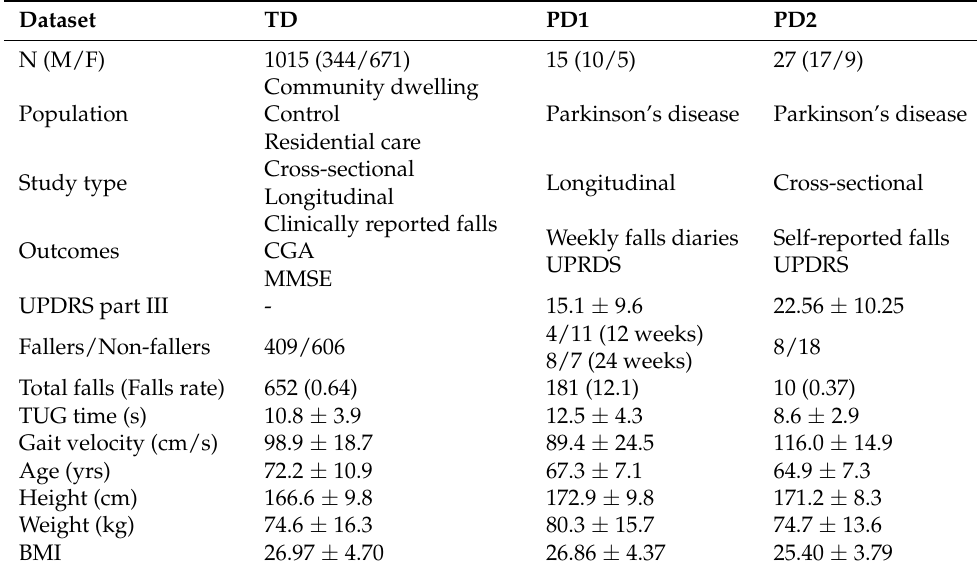
Table 1. Summary details per dataset. MMSE refers to Mini Mental State Examination. CGA refers to Comprehensive Geriatric Assessment, includes vision, blood pressure and medication review. BMI refers to Body Mass Index. UPDRS refers to Unified Parkinson’s Disease Rating scale (UPDRS) part III. Falls rate is mean falls per patient. TUG time is the mean time to complete the TUG test, while gait velocity is mean stride velocity during the TUG. Falls rate is reported as the mean number of falls per patient over the study